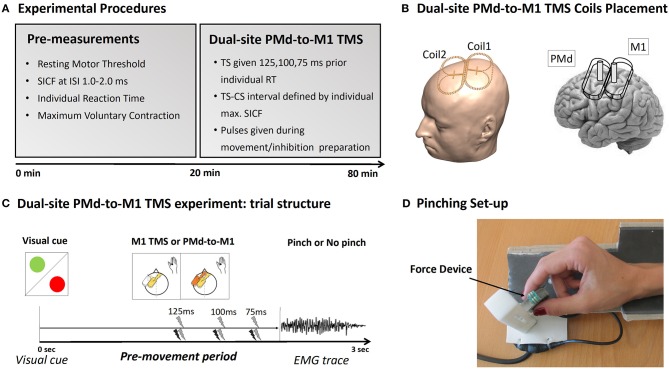
Experimental procedure. (A) Description of the experimental TMS procedure. (B) Placement of the mini-coils used during the experiment. (C) Plot of the Pinch-NoPinch experiment: subjects were instructed by a visual cue to either perform a pinch movement (green circle) or to refrain from preforming the movement (red circle). Single-site TMS over M1 and dual-site TMS over PMd-M1 were given 125, 100, or 75 ms before movement onset. (D) The pinch grip device used during the experiment.